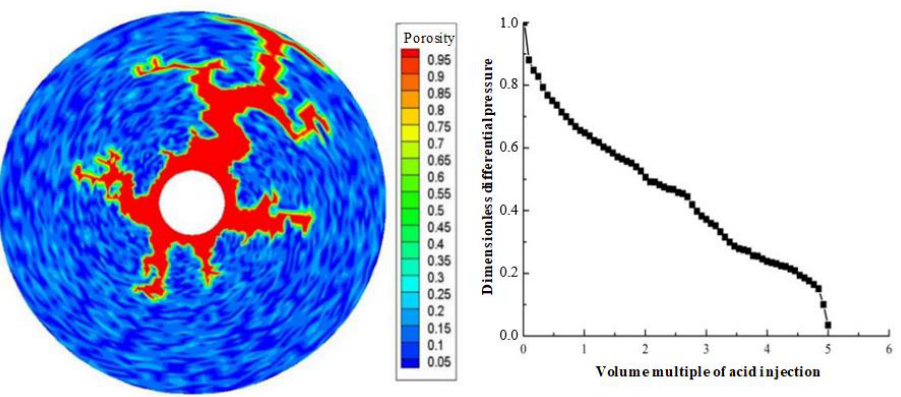
Figure 2. Change of dissolution form and differential pressure with gelling acid injection volume (gelling acid injection speed 0.0135 cm/min).